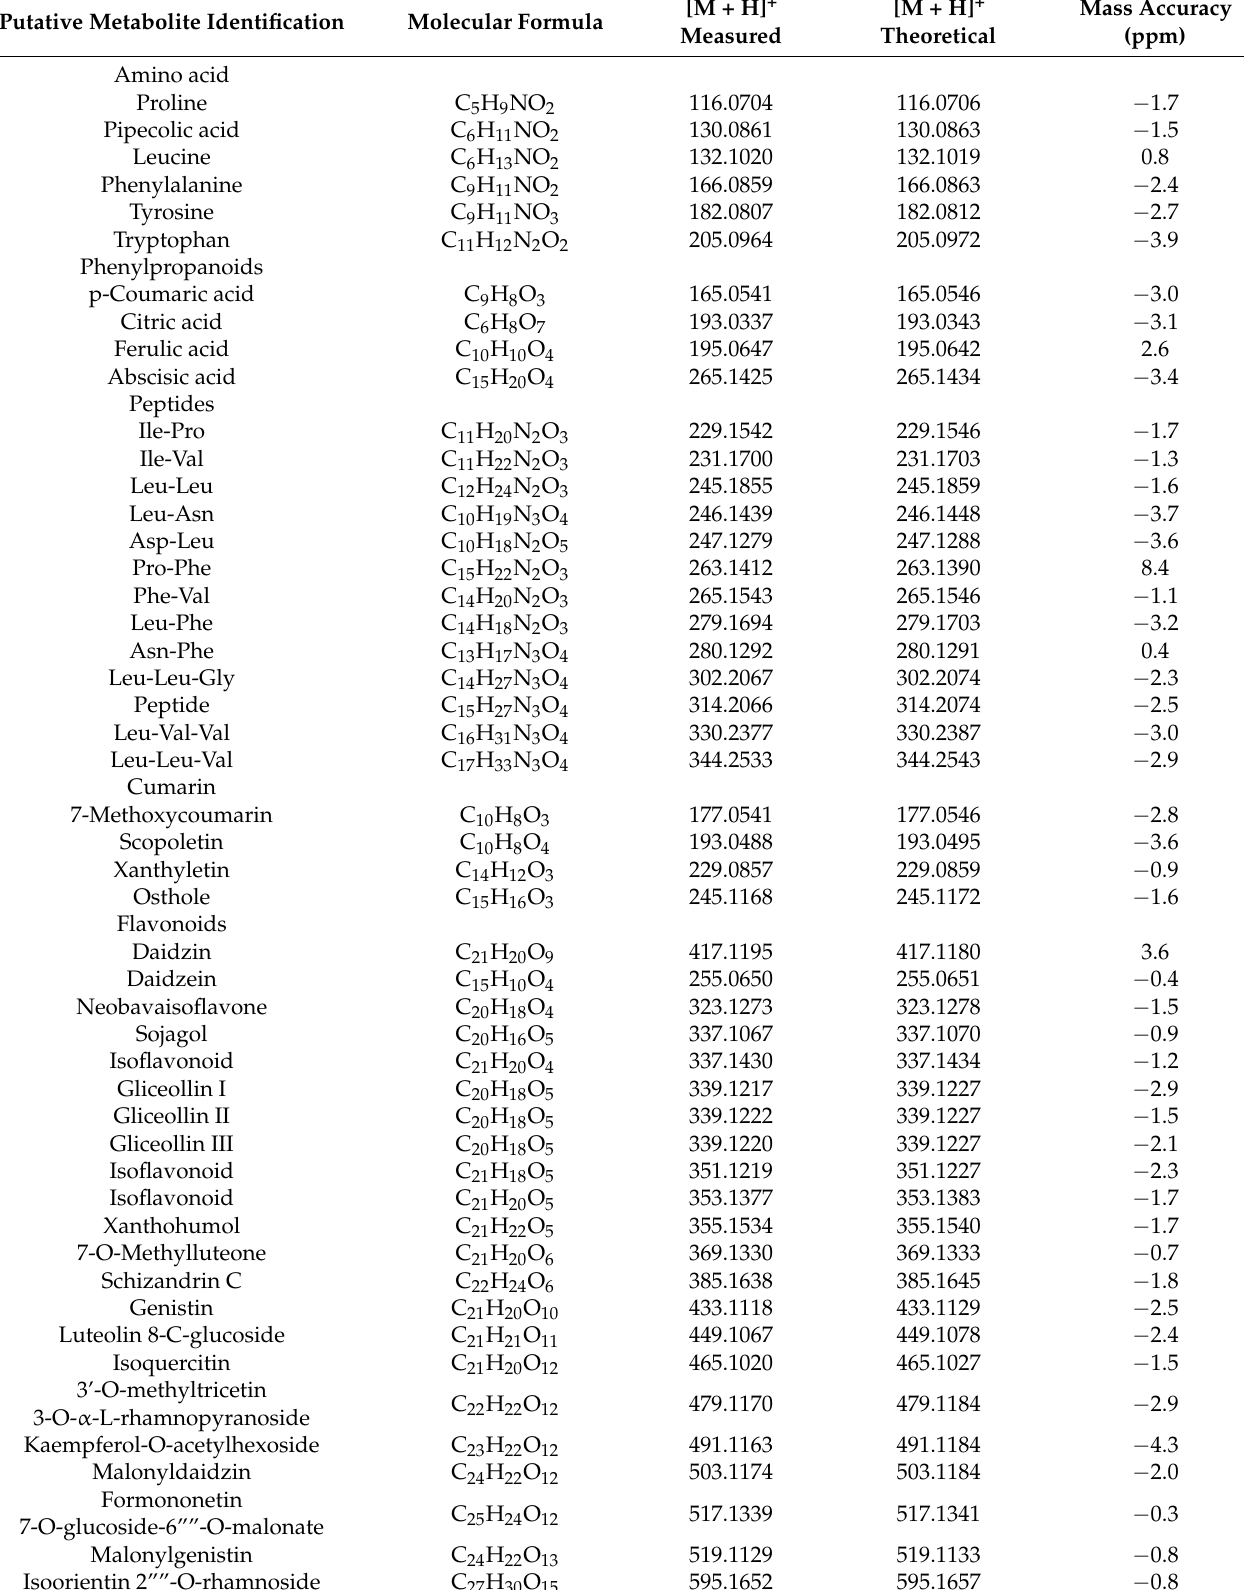
Table 1. Metabolites are putatively identified in soybean